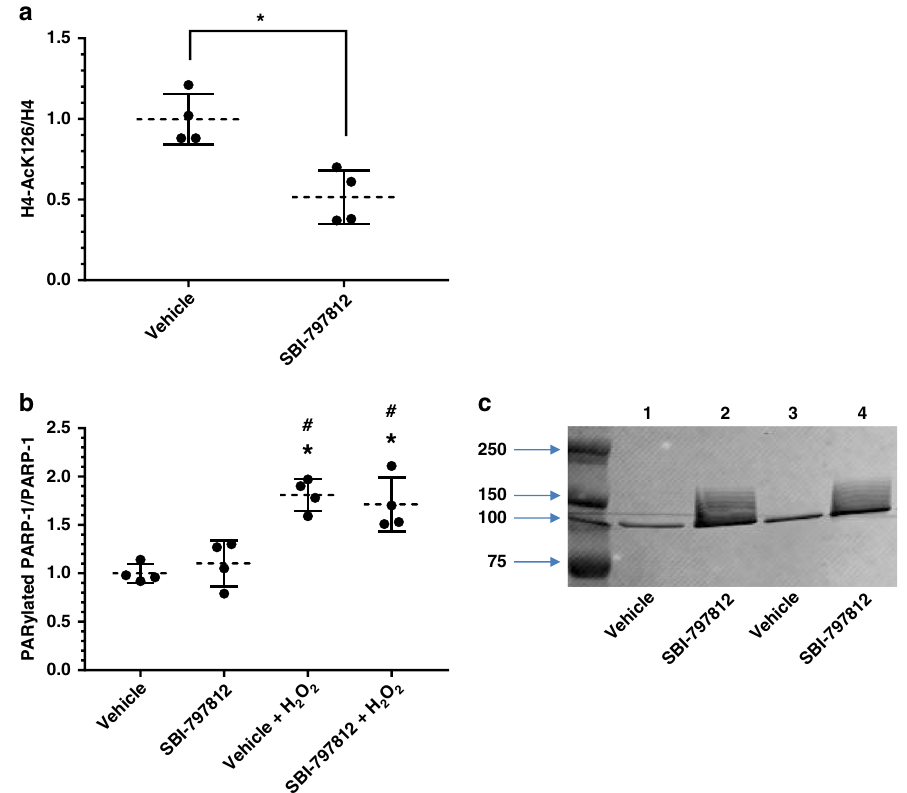
Fig. 5 Exploring the impact of SBI-797812 on sirtuin and PARP-1 activities. a SBI-797812 decreases histone H4 acetylation. A549 cells treated with vehicle or SBI-797812 (10 μ M) for 4 h. Histone H4 and H4-AcK16 levels determined by western blotting. Normalized signal ratios are shown. * p = 0.005 vs. control; n = 4. Two-tailed unpaired t test used. b , c Impact of SBI-797812 on PARP-1 activation. A549 cells treated with vehicle or SBI-797812 (10 μ M) for 4 h. Where indicated, A549 cells were also treated with H 2 O 2 (0.5 mM) for 30 min before harvest. Cell lysates were prepared with ( b ) or without ( c ) olaparib and analyzed by western blotting. Cell lysates probed with PAR and PARP-1 antibodies ( b ). Signal intensities determined with Licor Imaging system. PAR:PARP-1 signal ratios normalized to vehicle, no H 2 O 2 (assigned value = 1). Data shows means ± s.d., n = 4. * p < 0.002 vs. vehicle; # p < 0.01 vs. SBI-797812. One-way ANOVA with Tukey ’ s multiple comparisons test. Panel c shows western blotting of A549 cells treated with vehicle or SBI-797812 (10 μ M) for 4 h; cell lysates prepared without olaparib and probed with anti-PAR antibody. For Fig. 5a – c, source data are provided as a Source Data fi